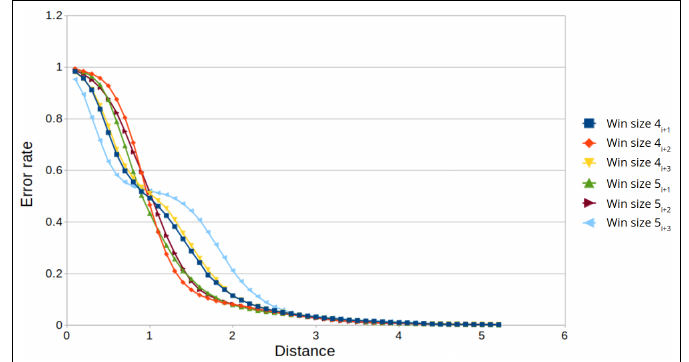
Figure 14. The FPR for a window size of 4 and 5 frames and an altitude of 50 m.